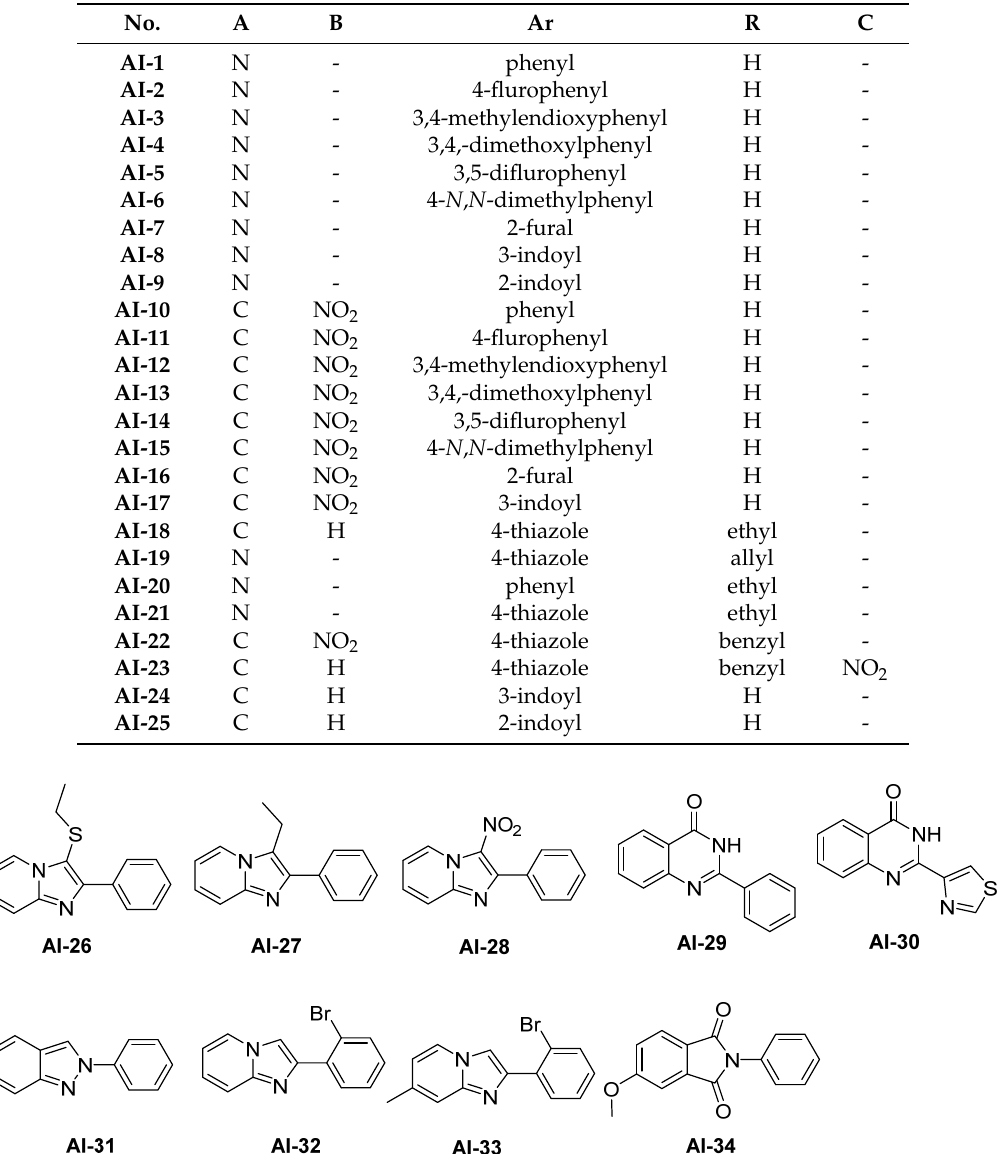
Figure 2. Benzimidazole scaffold hopping compounds.